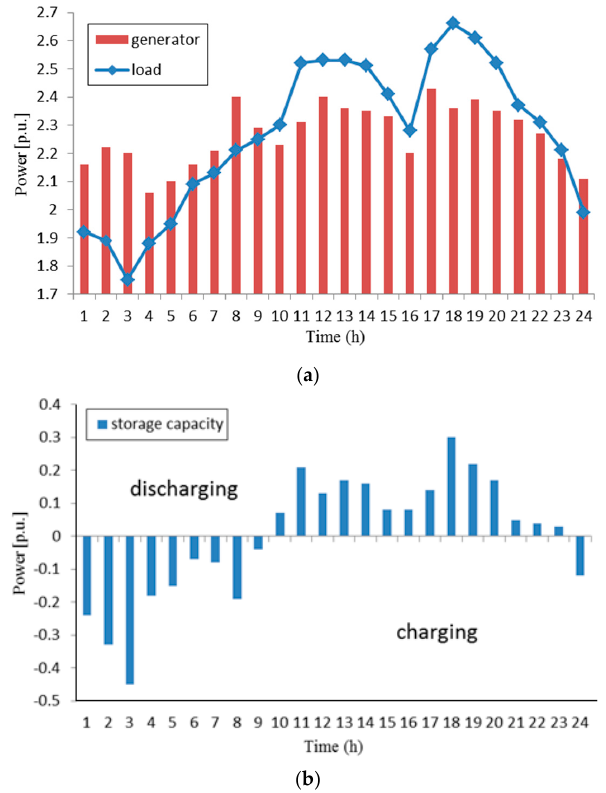
Figure 5. ( a ) Hourly generator output with HNS; ( b ) Storage active power capacity. Effect of charging/discharging strategy in the modified IEEE-14 bus